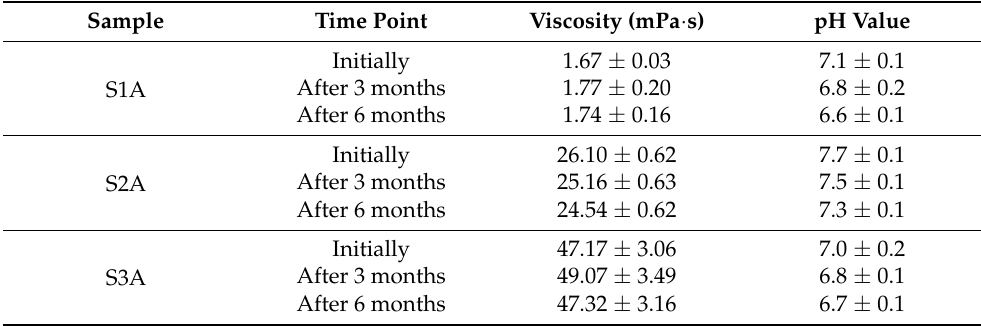
Table 2. Viscosity and pH values of the BDP-loaded FFS over 6 months of storage at room temperature (mean ± SD, n =